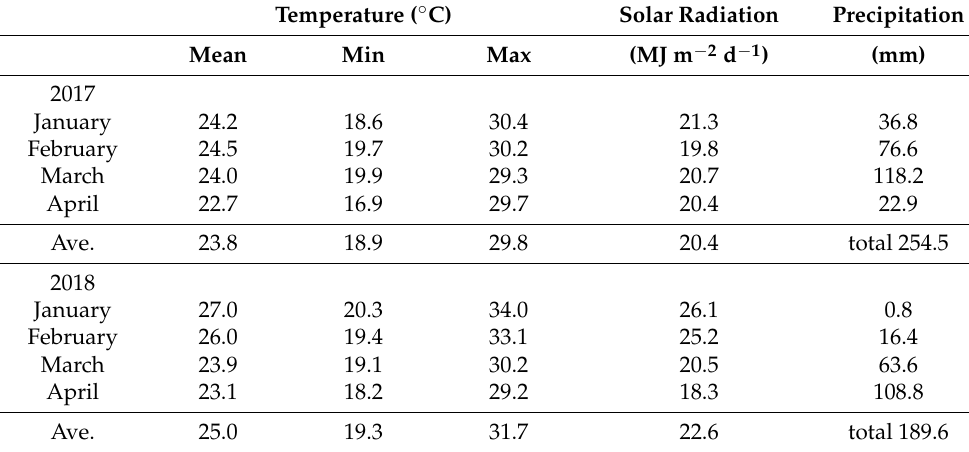
Table 1. Daily mean temperature ( ◦ C), solar radiation (MJ m − 2 d − 1 ) and monthly precipitation (mm) during the crop growth